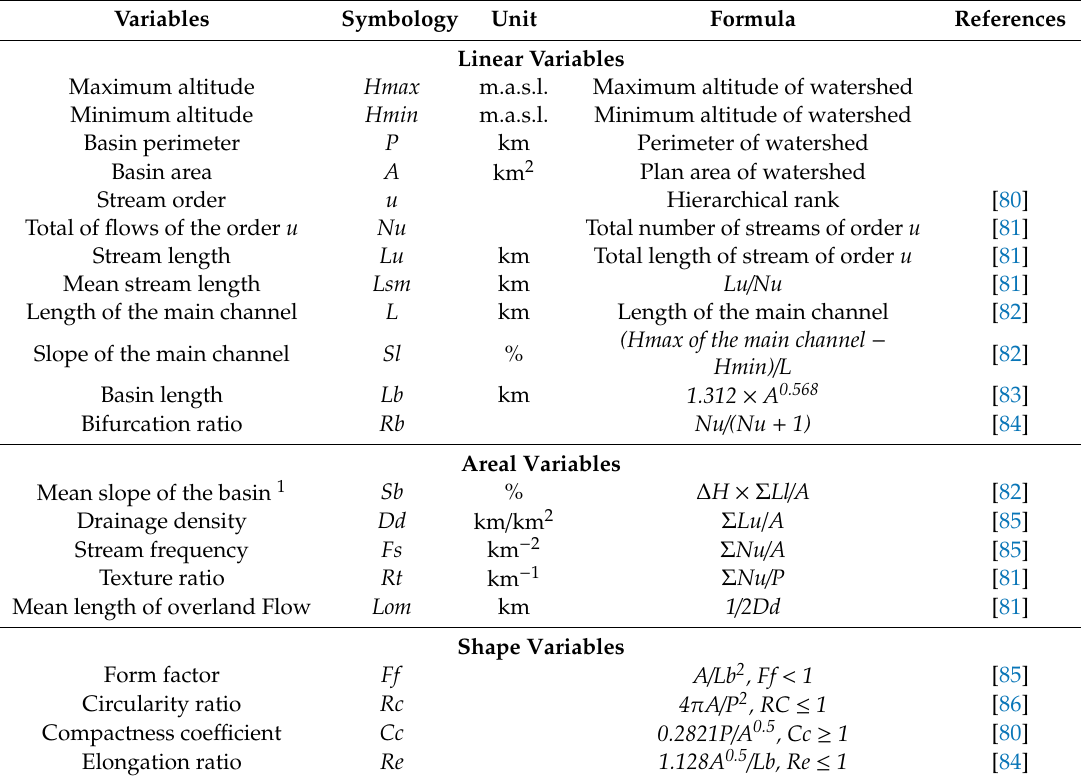
Table 1. Linear, areal, and shape morphometric variables and computation formulae with